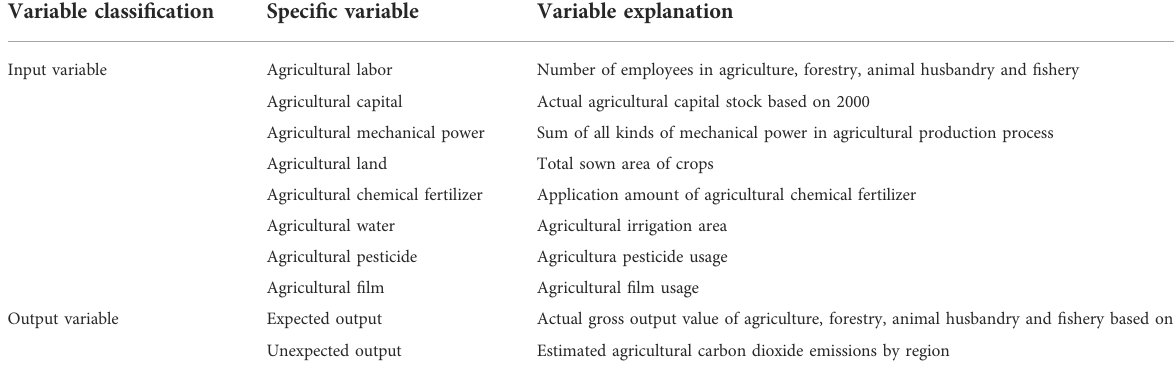
TABLE 1 Input-output variables of